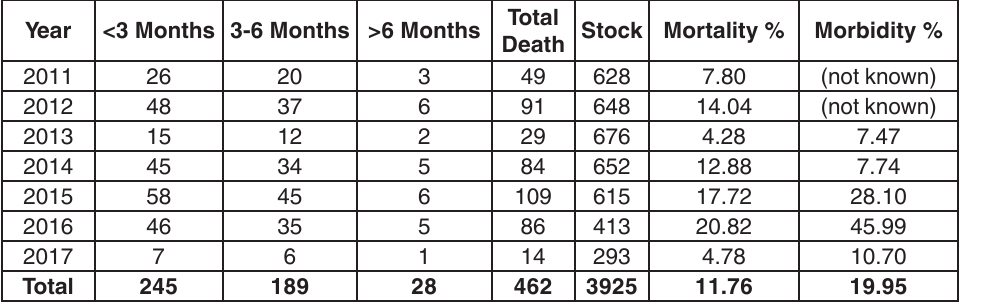
Table 1: Percent mortality and morbidity in different age groups of goats